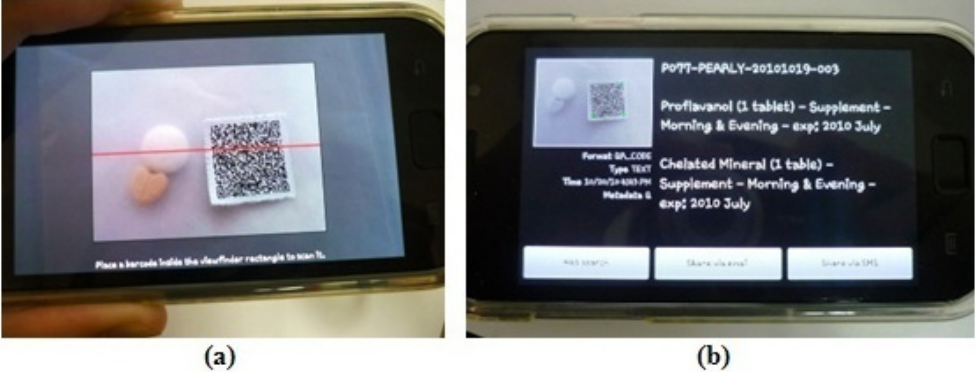
Figure 14. Personalized medicine care assistance: ( a ) Screen capture of mobile barcode decoder trying to decode the personalized QR barcode; ( b ) Display of decoded data on mobile